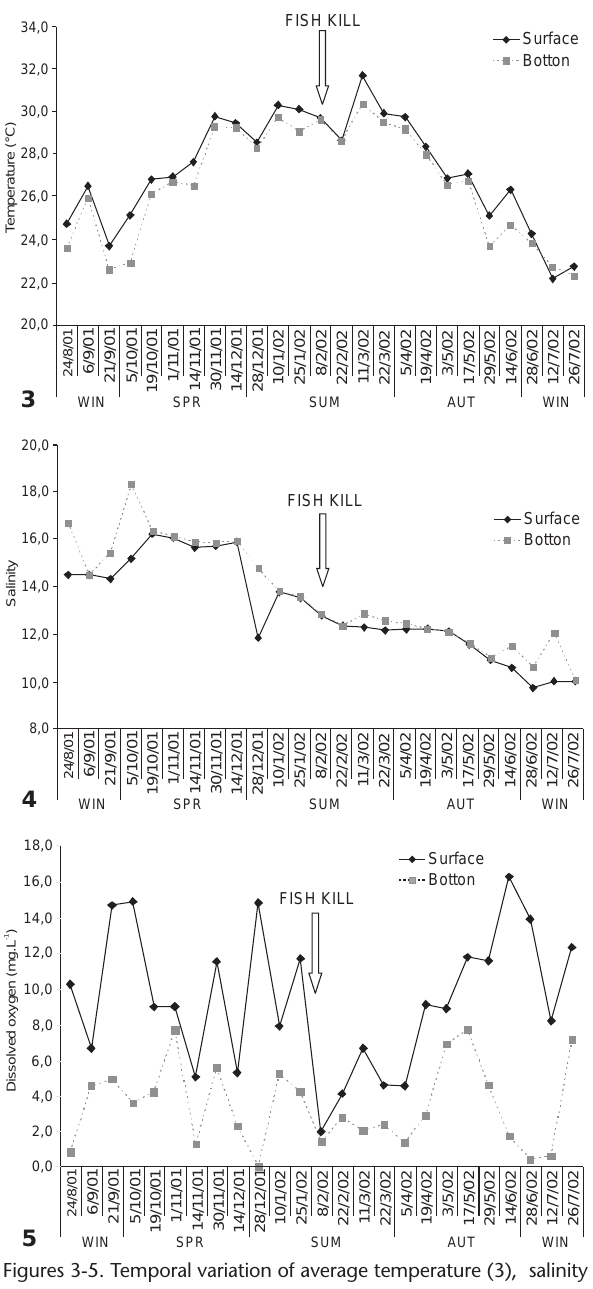
Figures 3-5. Temporal variation of average temperature (3), salinity (4), and DO (5) at the surface and at the bottom (August 2001 to July 2002). (WIN) Winter, (SPR) spring, (SUM) summer, (AUT)